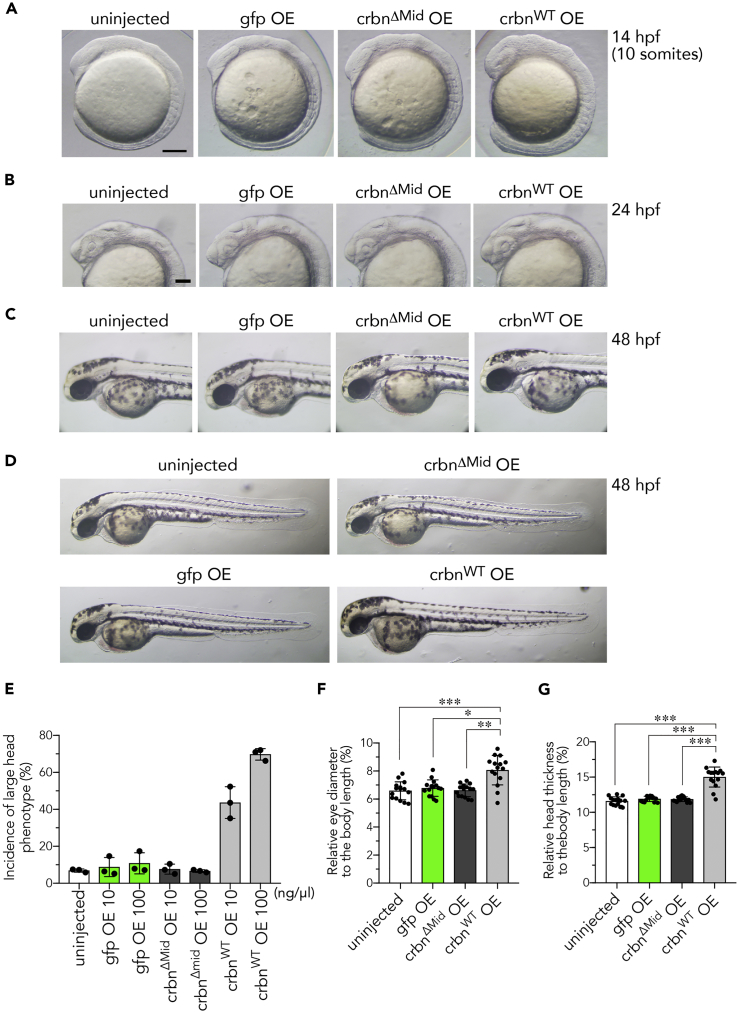
Overexpression of crbn Enlarges the Head(A–D) Head enlargement in crbnWT-overexpressing embryos at the 10-somite stage (14 hpf) (A), 24 hpf (B), and 48 hpf (C and D). One-cell-stage embryos were left uninjected or injected with approximately 300 pg of capped mRNA (300 ng/μL) encoding gfp, crbnΔMid, or crbnWT.(E) One-cell-stage embryos were left uninjected or injected with capped mRNA at the indicated concentration. The head sizes of 14-hpf embryos were classified into “large” and “normal” based on the head-to-body ratio using the following criteria: ≤8%, normal; >8%, large. The fractions of large head embryos are shown as means ± SD (n = 3 per group).(F and G) The ratios of eye diameter (F) and head thickness (G) to body length were determined at 48 hpf as in Figures 1B–1D and are shown as means ± SD (n = 15 per group).Scale bar, 50 μm in (A and B). *p < 0.05, **p < 0.01, ***p < 0.001.